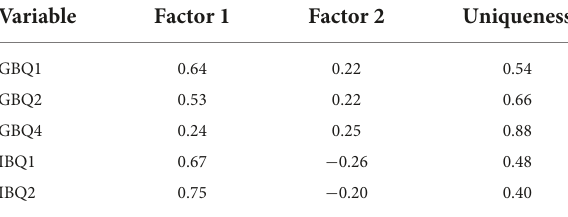
TABLE 2 Factor loadings (pattern matrix) and unique